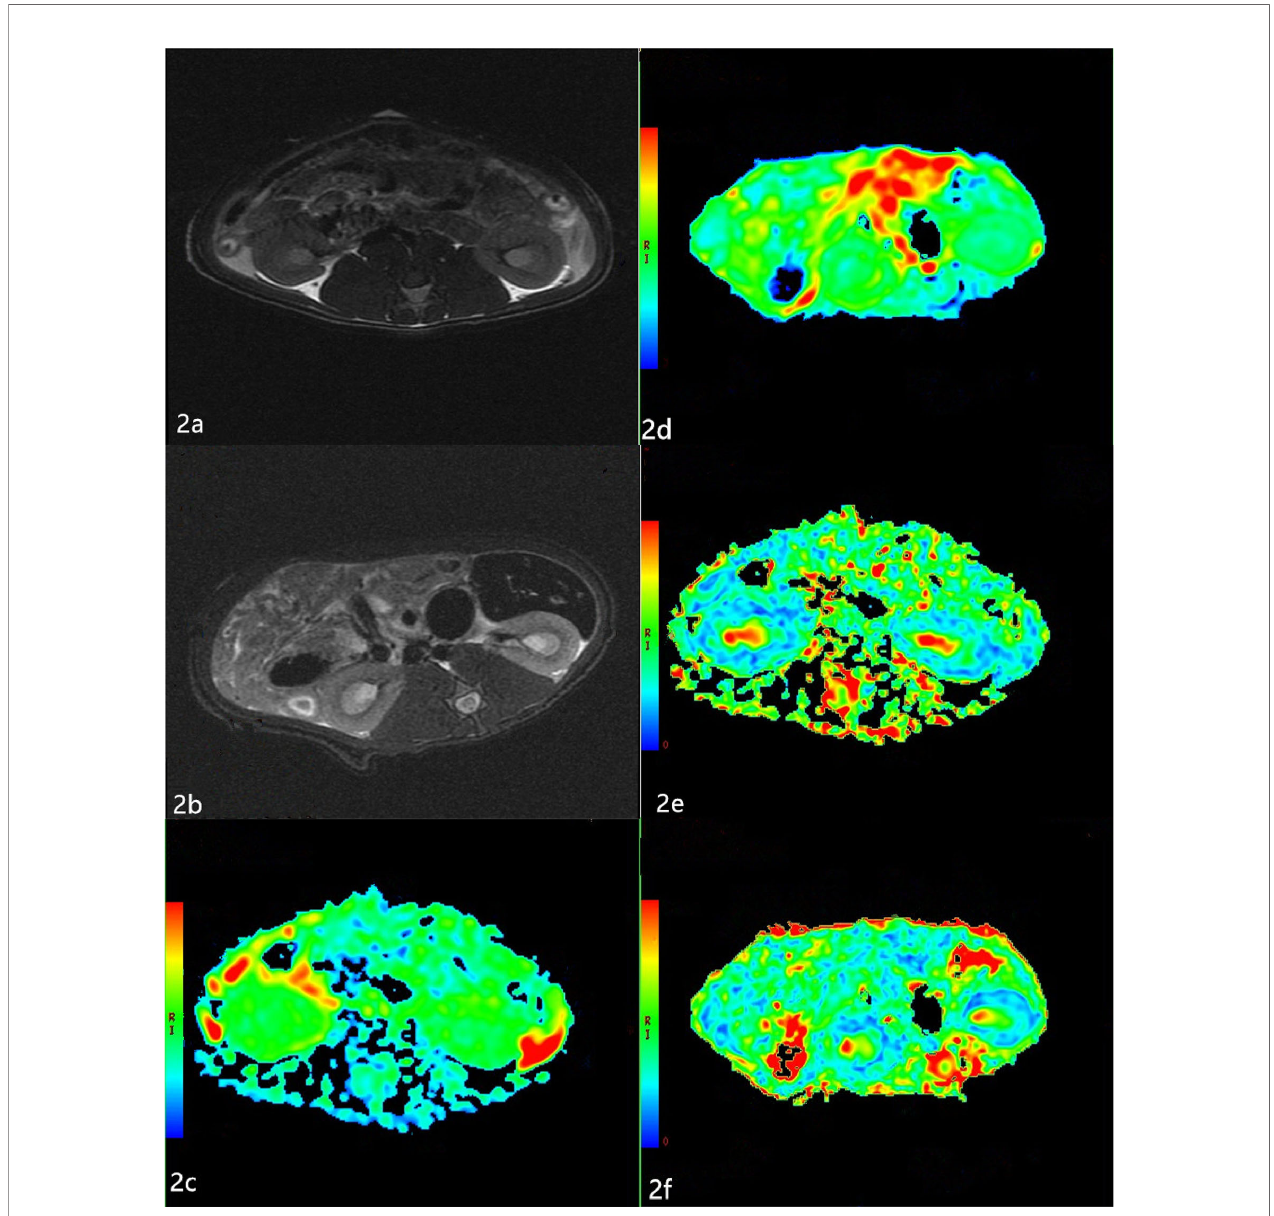
FIGURE 2 | Apparent diffusion coef fi cients (ADC) and Fractional anisotropy (FA) maps of the two groups (A, B) The T2-weighted images of the two groups. T2- weighted images show no obvious changes in the morphology and structure of the kidneys between the two groups, and there is clear differentiation between the renal cortex and medulla. (C, D) The ADC maps of the NC group and DN group. The boundary of the cortex and medulla are clear in the NC group. The resolution of the cortex and medulla of the kidneys in the DN group is indistinct. (E, F) The FA maps of the NC group and DN group. The boundary of the cortex and medulla are clear, but the color resolution of the renal cortex and medulla is lower in the DN group than in the NC group.